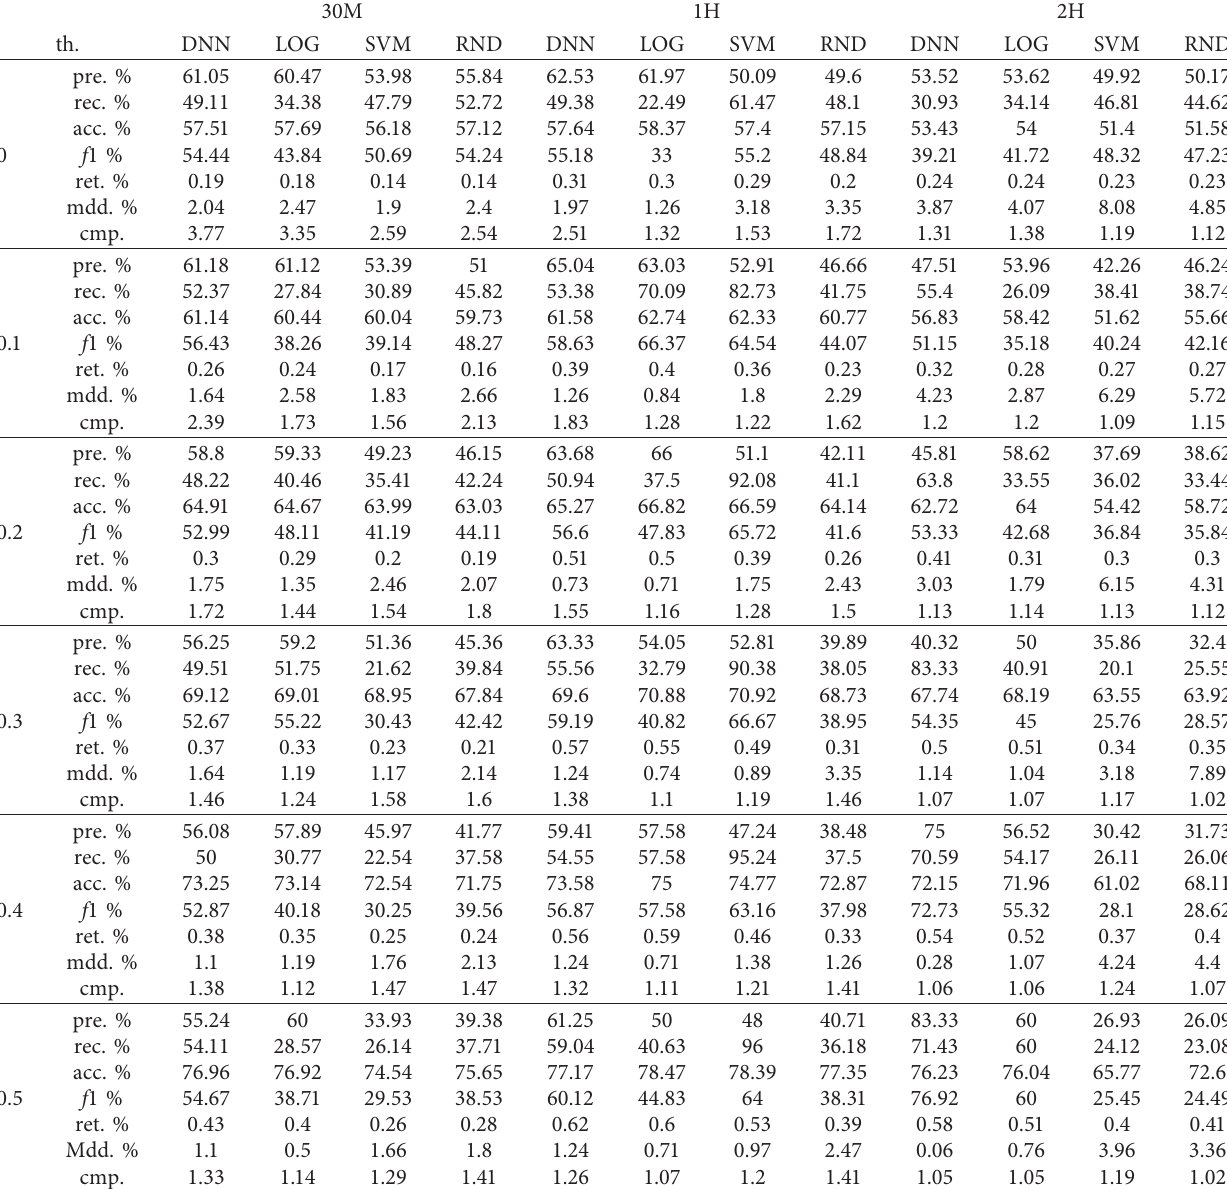
Table 6: Results of falling direction